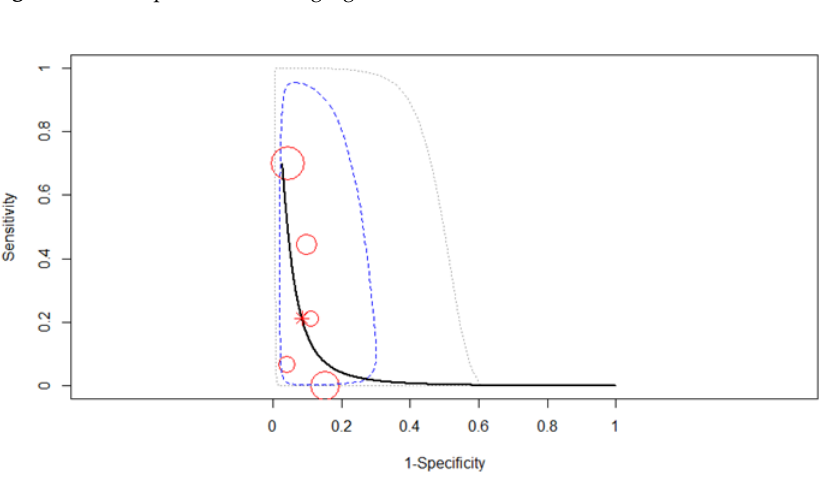
Figure 5. SROC curve for T2 restaging. Dotted blue curve: 95% confidence region; dotted closed curve: 95% prediction region for T2 staging.